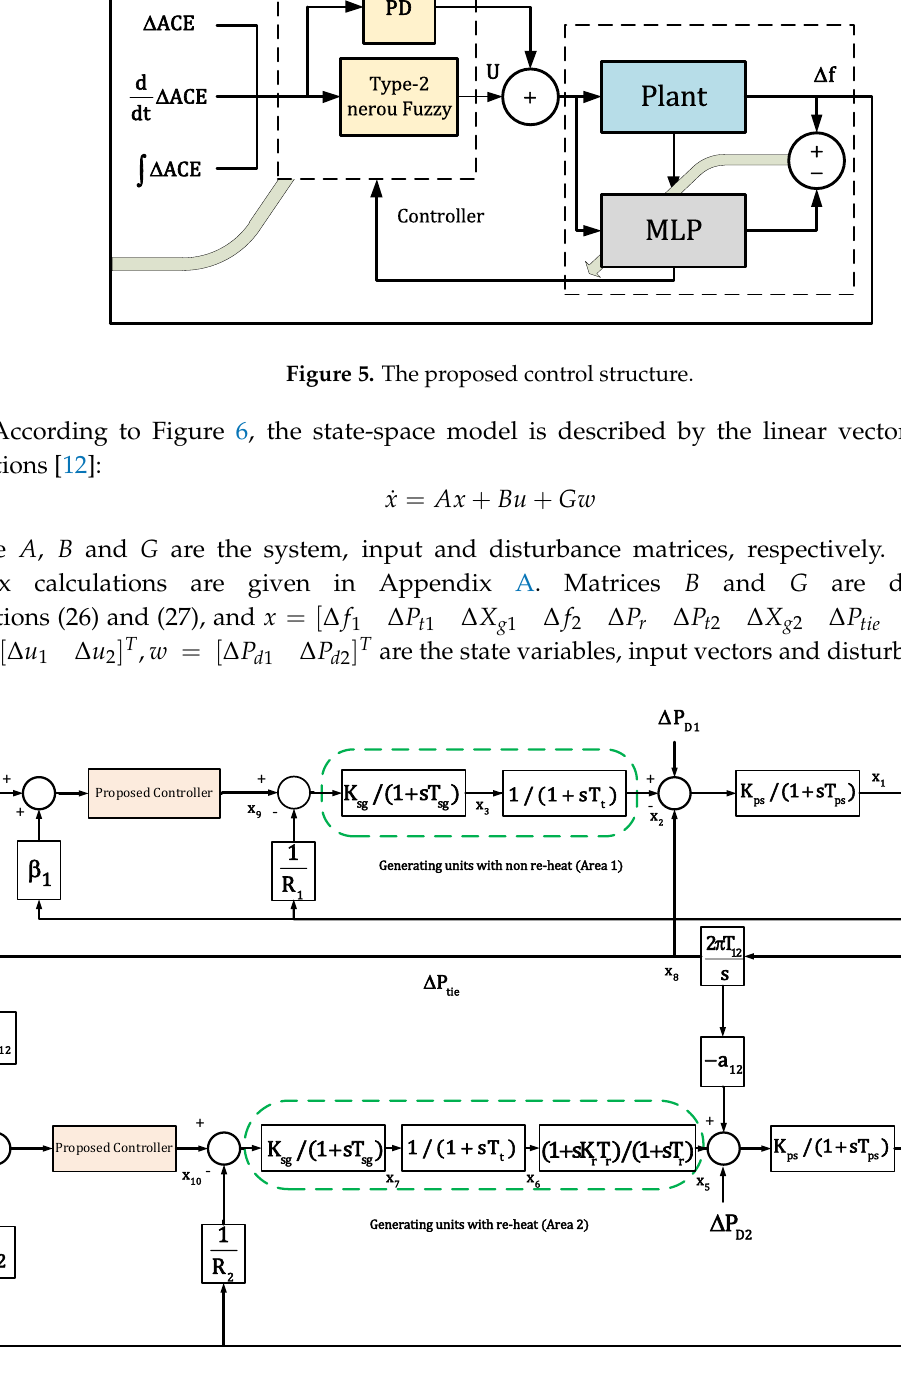
Figure 6. Two-area load frequency control (re-heat and non